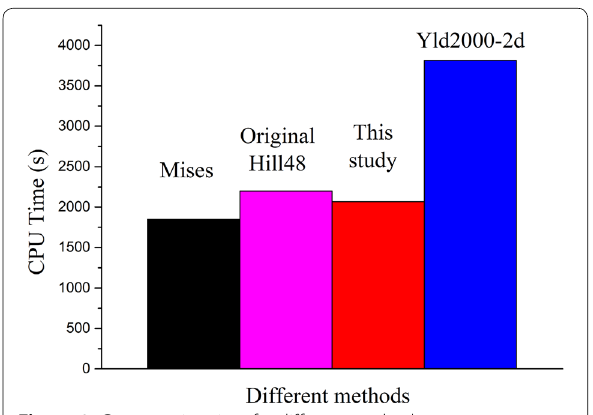
Figure 8 Computation time for different